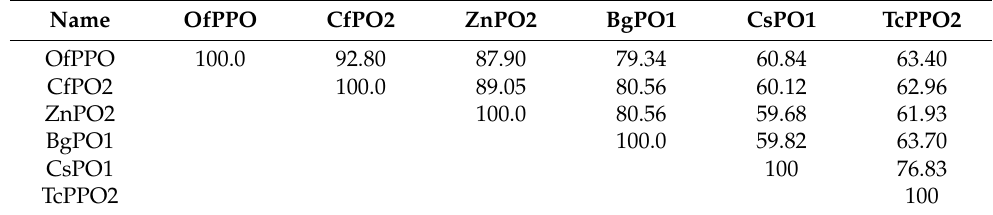
Table 1. Percentage of similarity among six PPO amino acid sequences calculated using MEGA X.